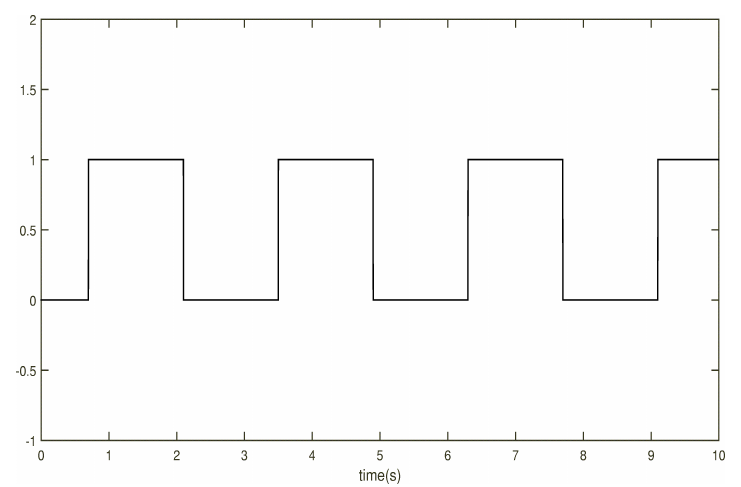
Fig. 5. Switching signal of system (1) with